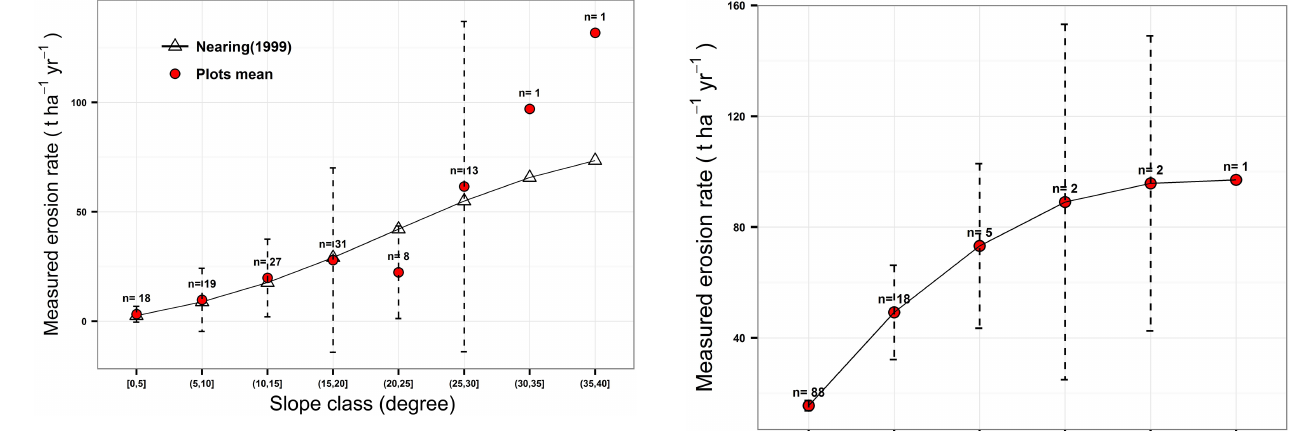
Figure 2. Weighted mean and standard deviation of the soil top- soil erosion rate for different slope classes of arable land on the CLP as derived from the erosion plot database. (Relative) variations predicted using the model of Nearing (1999) are also indicated. The Nearing model excellently predicts relative variations in ero- sion rates up to a slope of 30 ◦ and was therefore used in this study. Comparison of model predictions and observations at higher slope gradients is not relevant due to the small number of observations.